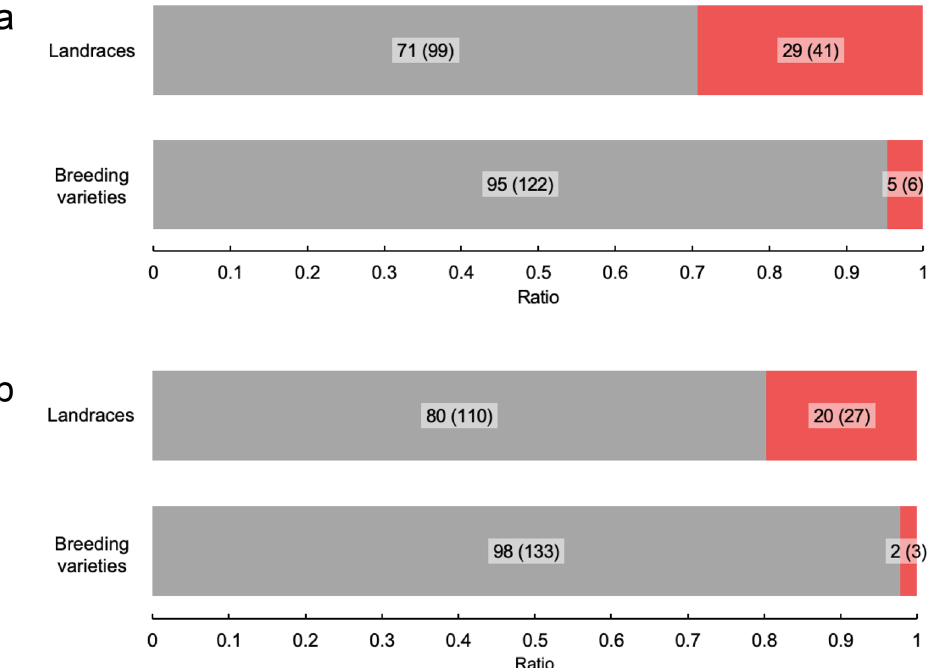
Figure 7. Ratio of genotypes per QTL for landraces and breeding varieties. Stacked bar graphs showing the ratio of genotypes at the peak: ( a ) on chr. 2L; ( b ) on chr. 3S. The grey and red bars indicate the reference and alternative genotypes, respectively. The numbers on the bars indicate the ratio, and the numbers in parentheses indicate the number of varieties.